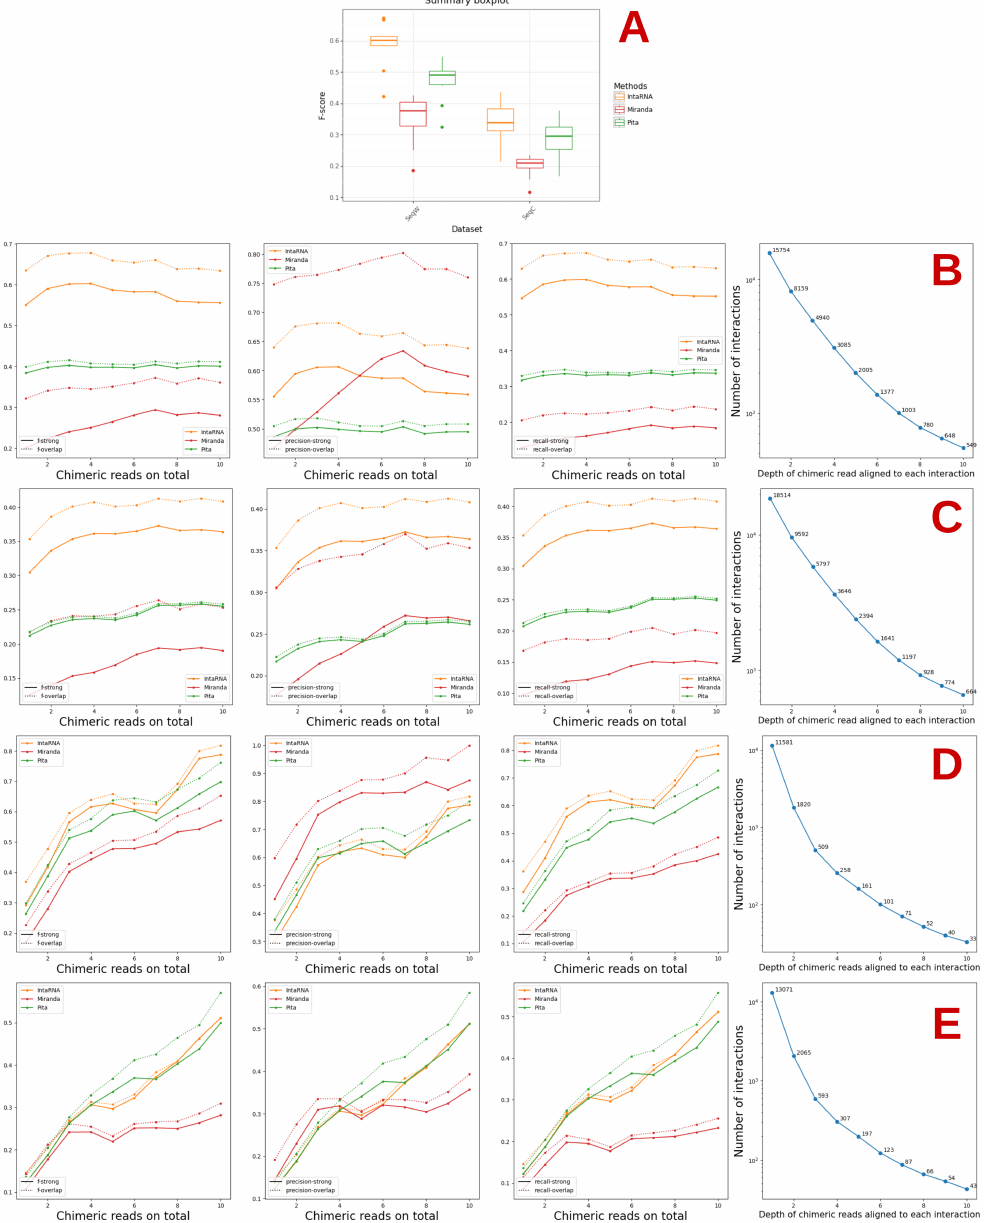
Figure 2. F-score, precision and recall for MI R ANDA , P ITA , and I NTA RNA used with default parame- ters. ( A ) summarises the results of the combined human and mouse datasets. ( B , C ) and, resp., ( D , E ) show the results on the Seq W and Seq C human, resp. mouse,